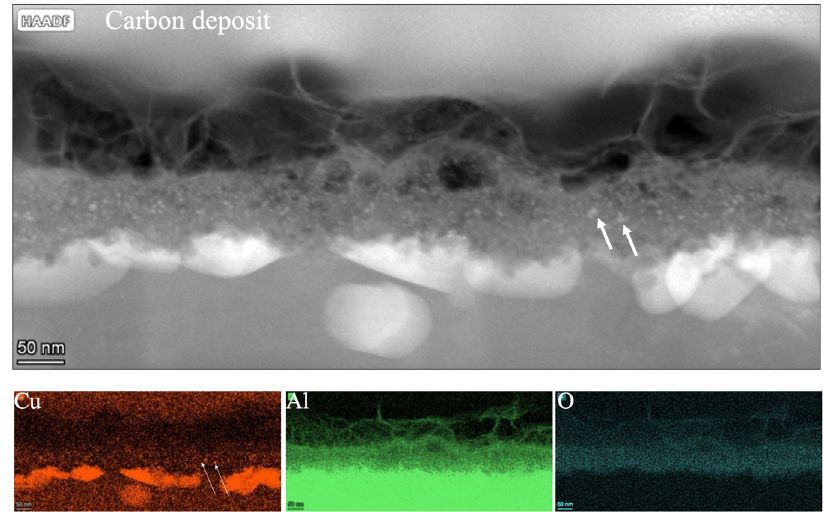
Fig. 7 Post-mortem analysis of the conversion layer formed on the bulk alloy. Cross-sectional STEM/EDS analysis of the conversion layer. The white arrows point to the copper-rich regions in the conversion layer; see the Cu map. The lamella was fabricated with the lift-out FIB procedure out of the sample exposed to 5 mL of 0.01 M NaCl + 0.01 M Li 2 CO 3 solution for 7 h.